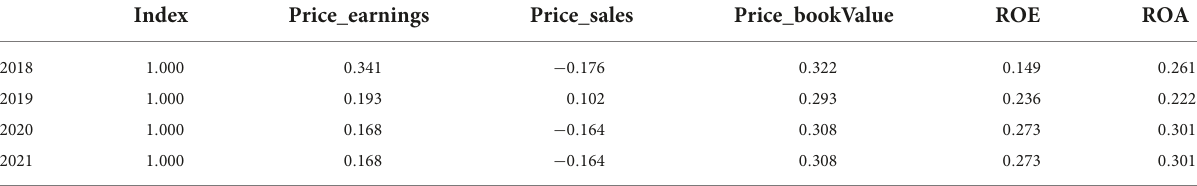
TABLE 4 Correlations (main